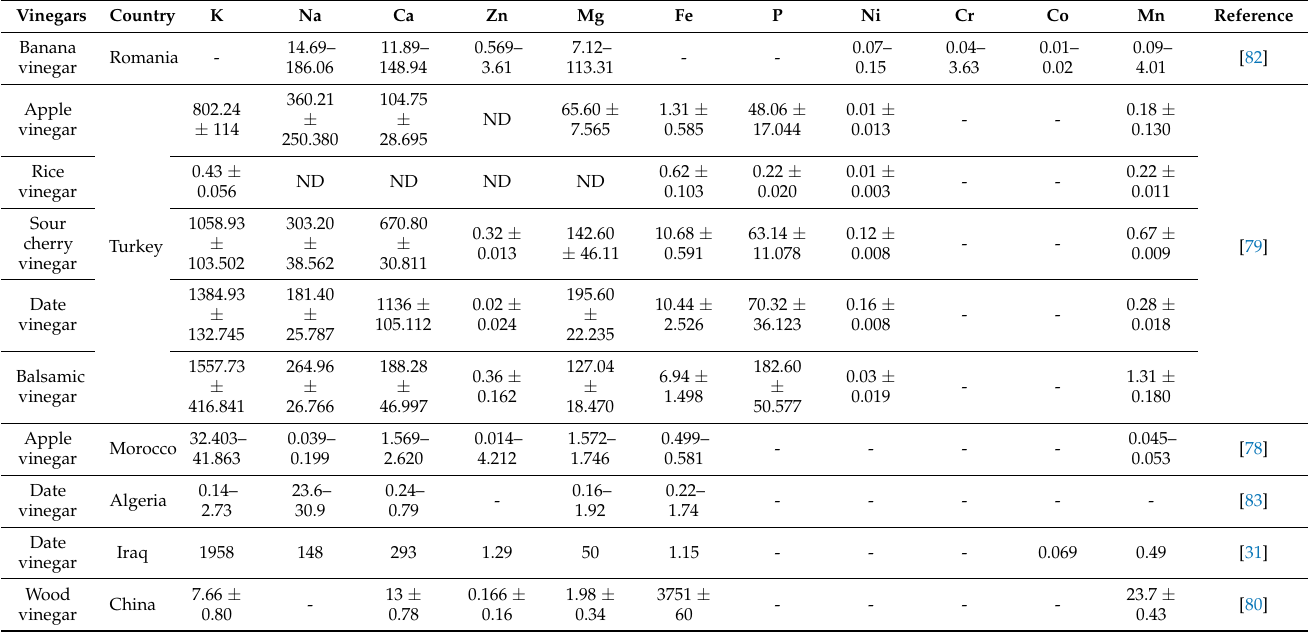
Table 4. Mineral composition of FsV